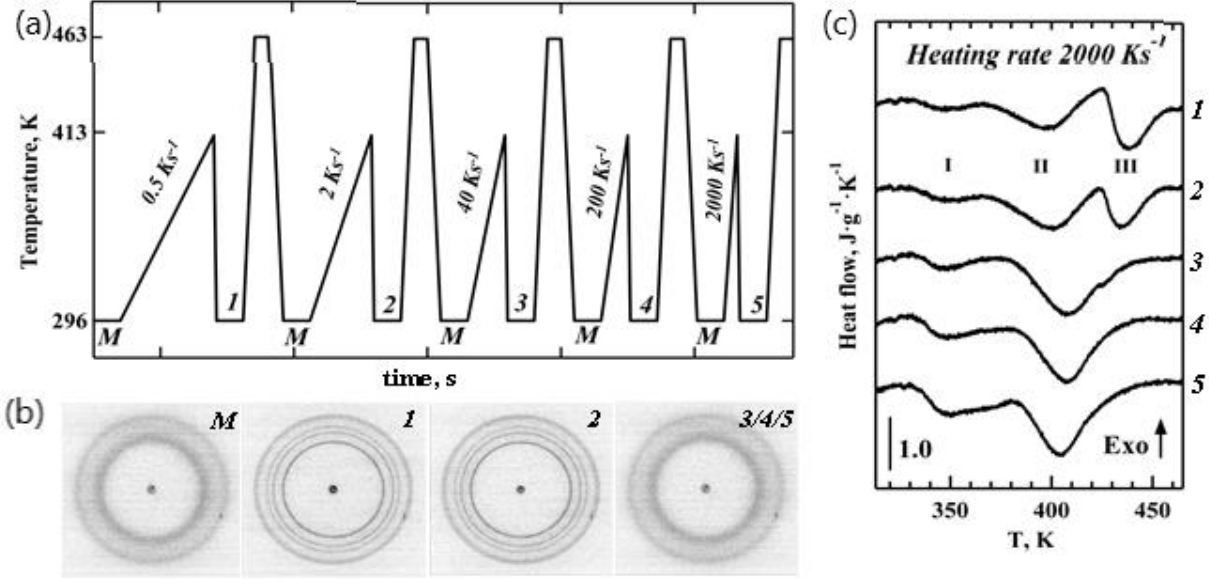
Figure 3. Effect of the heating rate on iPP crystal formation from mesophase. ( a ) TT profile used for the in situ X-ray structural studies; ( b ) two-dimensional WAXS patterns M 1 – 5 of iPP before and after applying different heating rates. ( c ) Heating endotherm probing states 1 – 5 at a constant rate of 2000 K s −1 . All of the endotherms are normalized by the sample mass and the heating rates. For the sake of clarity, images 3 , 4, and 5 of mesomorphic iPP are combined.